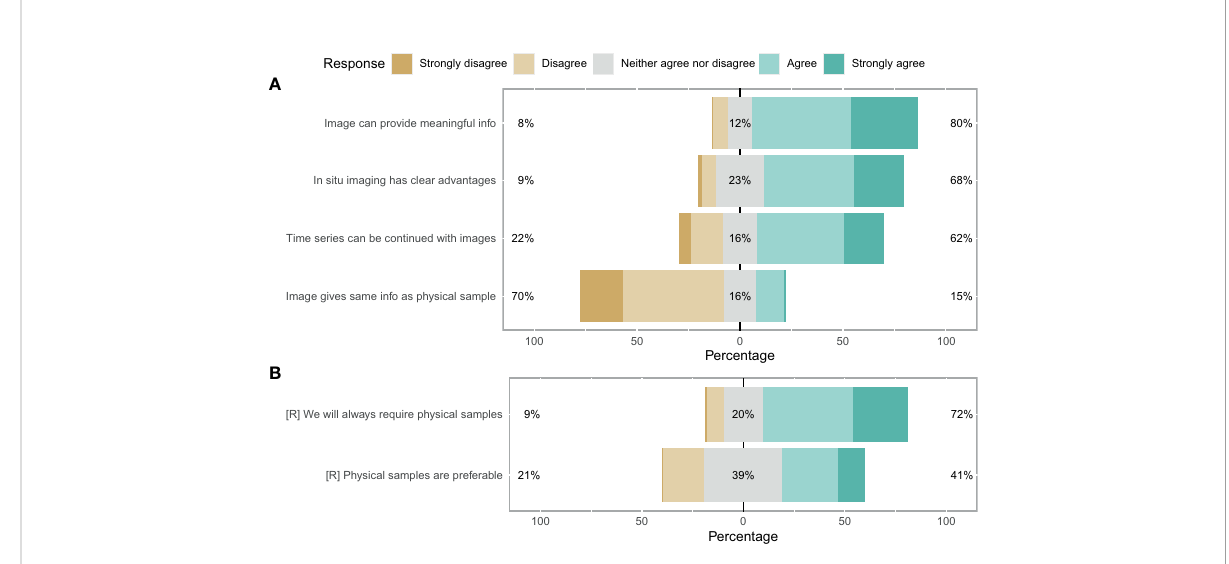
FIGURE 3 Likert plot for image suf fi ciency. (A) Darker green shows consensus favours replacement of physical samples with images. Darker brown means a preference for keeping the system as it is. An equal spread likely indicates no clear consensus. (B) Reverse as for (A)